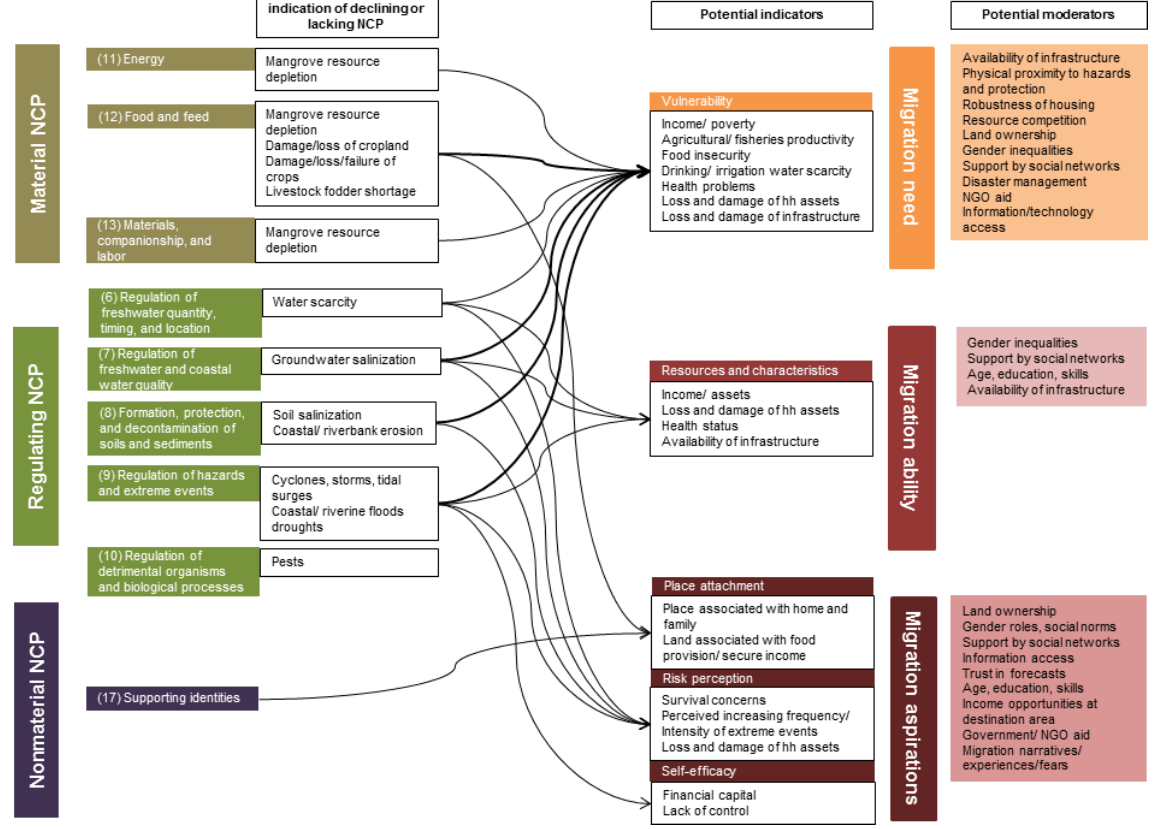
Fig. 1 . Links between nature’s contributions to people (NCP) and migration need, ability, and aspirations in southwestern coastal Bangladesh. Arrows drawn between these elements represent indications of connections found in the reviewed studies with bold arrows referring to particularly common and explicit connections, yet, are not to be understood as illustrating direct or monocausal